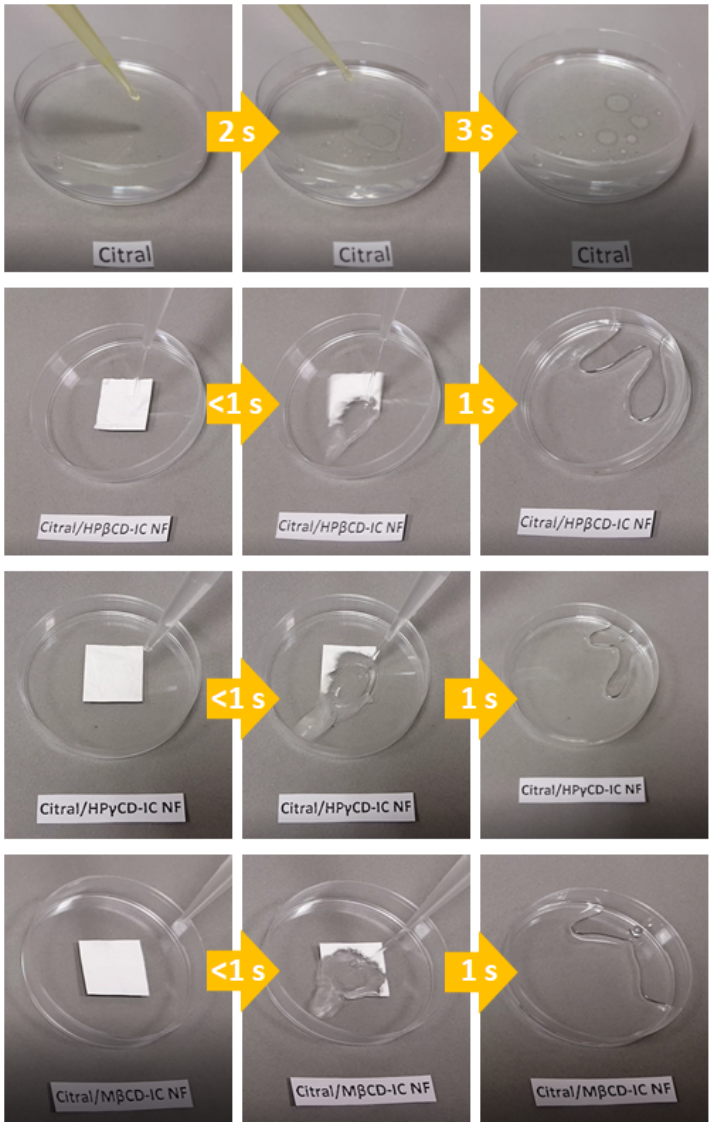
Figure 4. Presentation of the solubility behavior of pure citral and citral/HPβCD-IC-NF, citral/HPγCD-IC-NF, and citral/MβCD-IC-NF webs in water (the images were captured from the V ideos S1–S2).